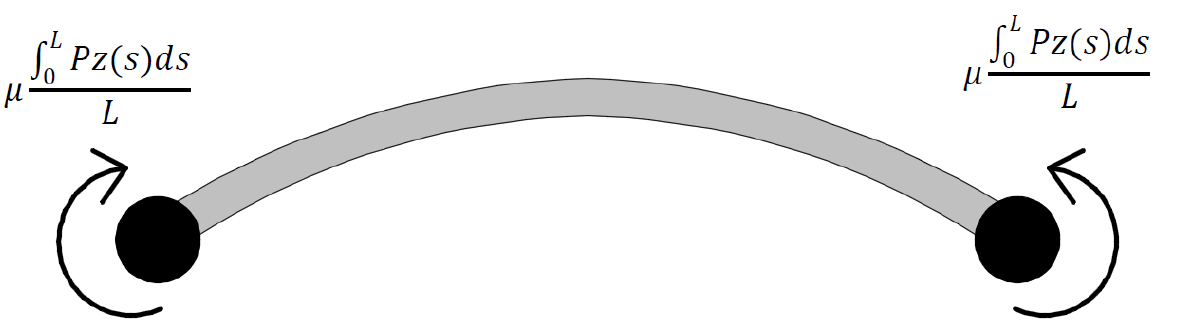
Figure 4. Prestressing equivalent nodal